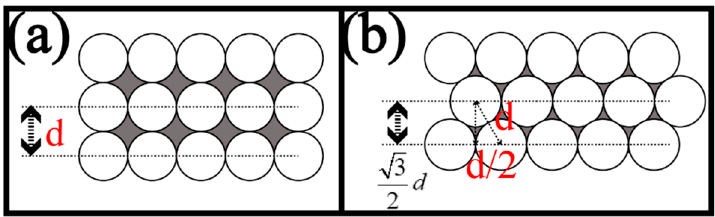
Figure 6. Optical fiber arrangement.